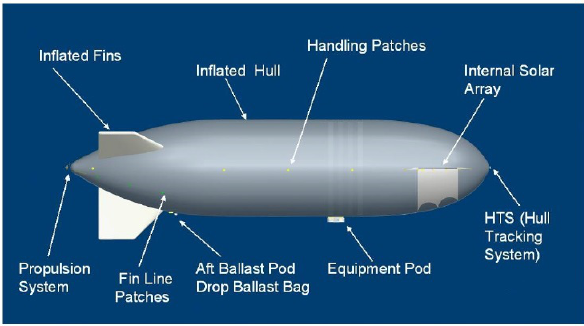
Figure 3. HiSentinel80 airframe configuration